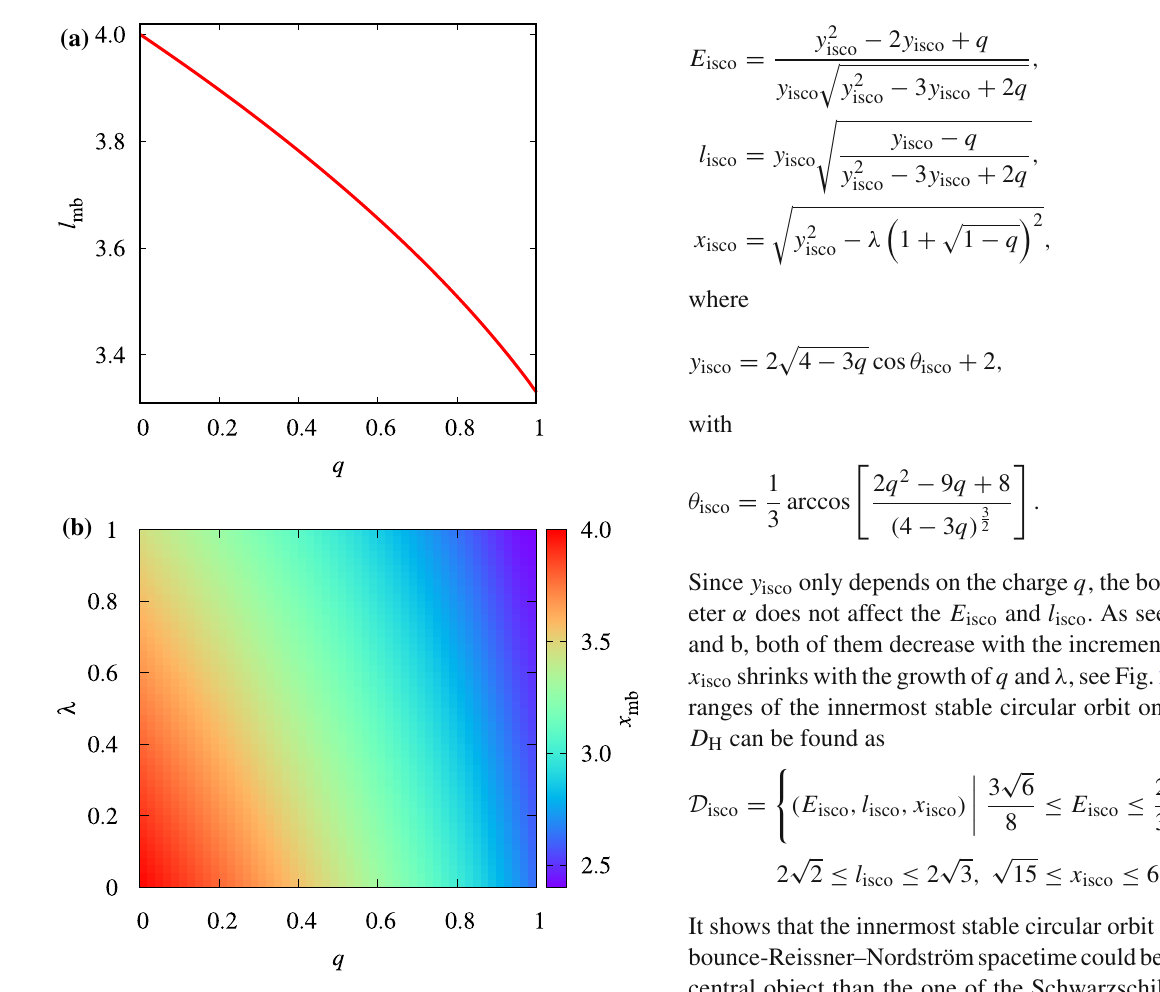
Fig. 1 The dimensionless angular momentum l mb and the dimension- less radius x mb of the marginally bound orbit for the black-bounce- Reissner–Nordström spacetime are shown on the domain of D H , where l mb is independent on